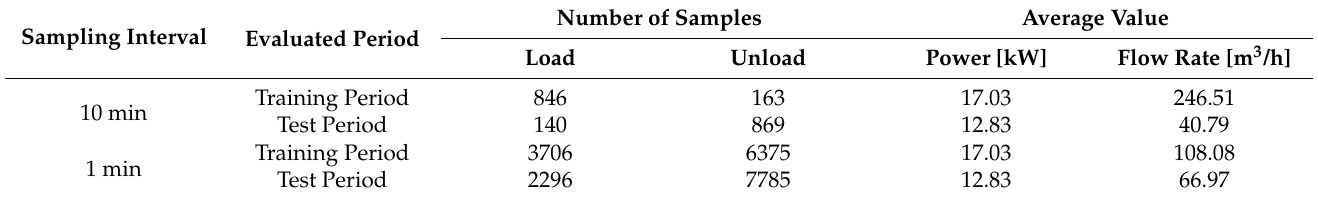
Table 2. Average air compressor power and flow rate during the different operation